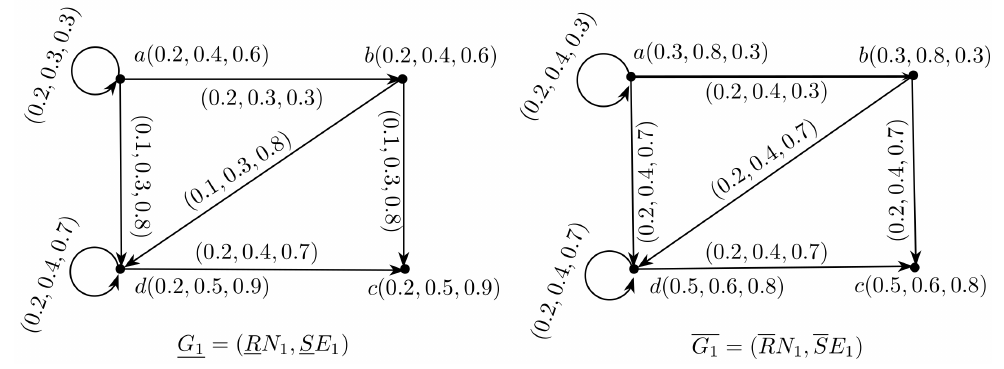
Figure 4. Rough neutrosophic digraph G 1 = ( G 1 , G 1 ) .